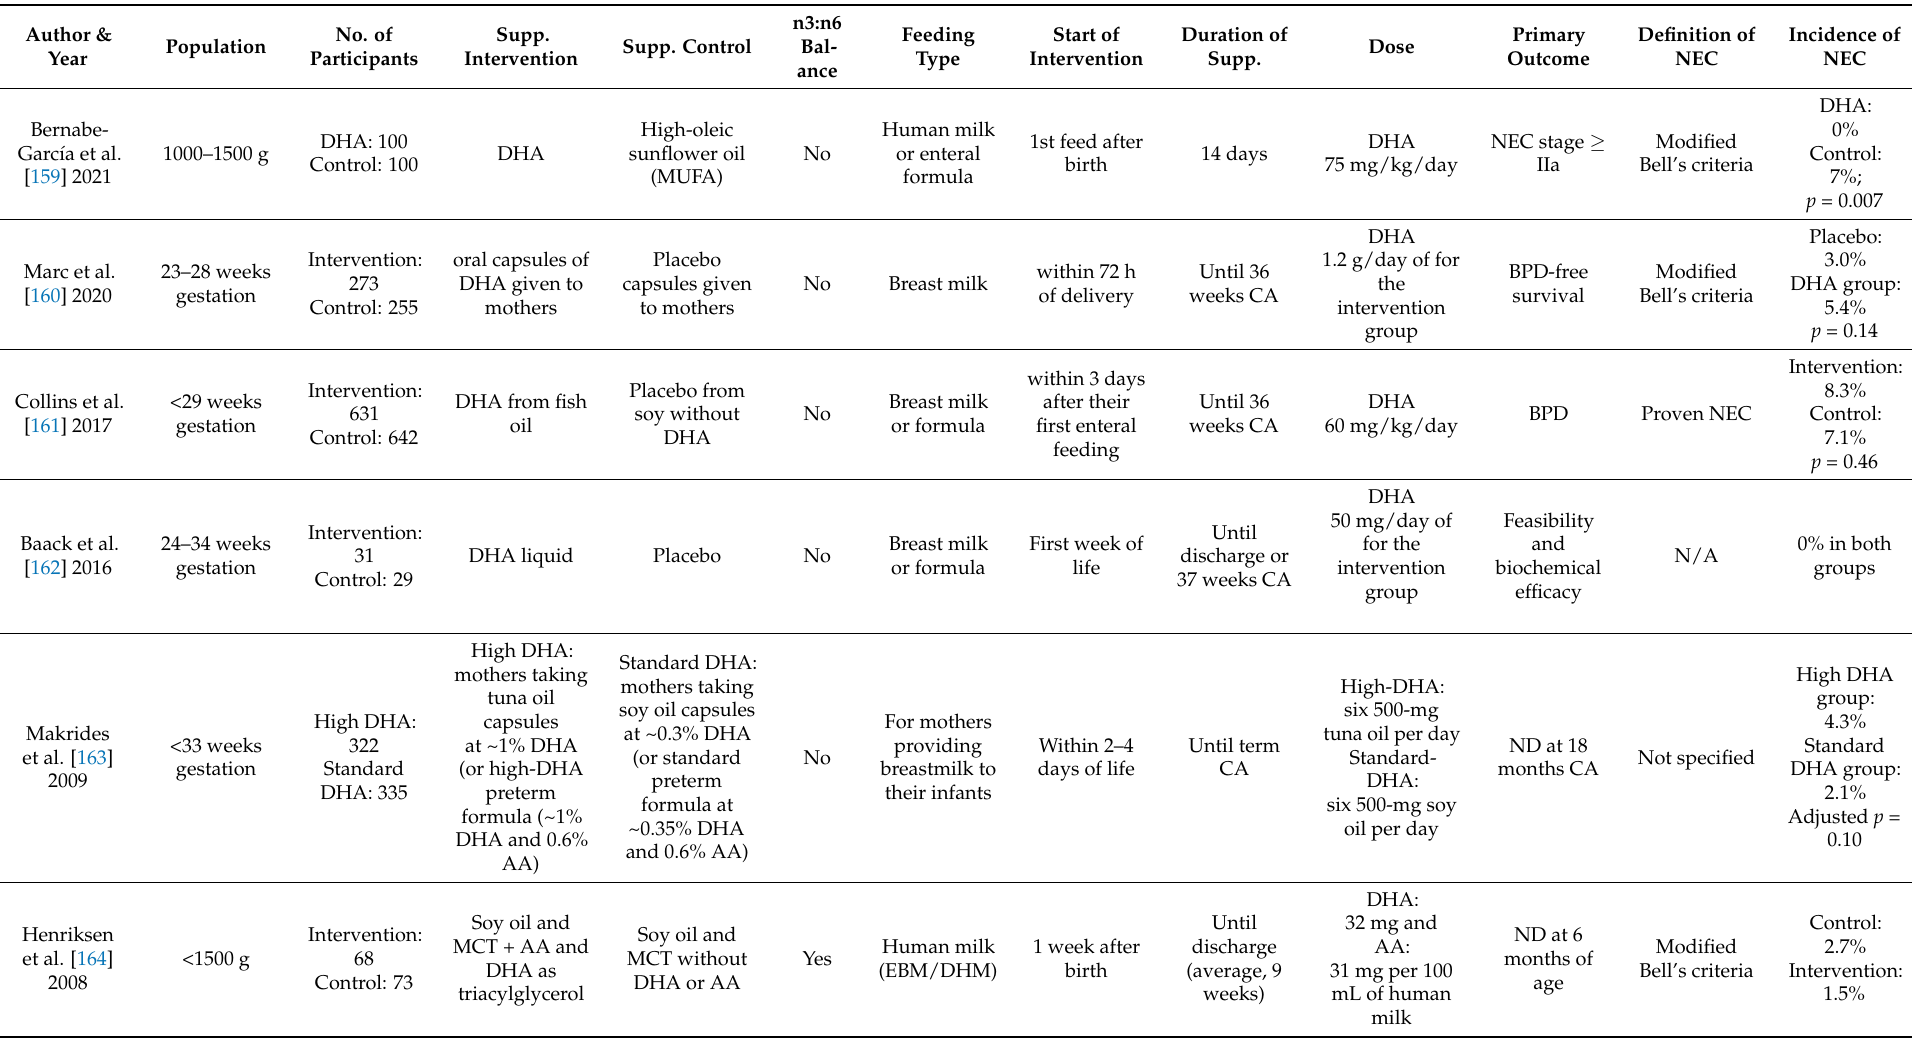
Table 2. Clinical trials of effect of enteral DHA on the risk of necrotizing enterocolitis in human